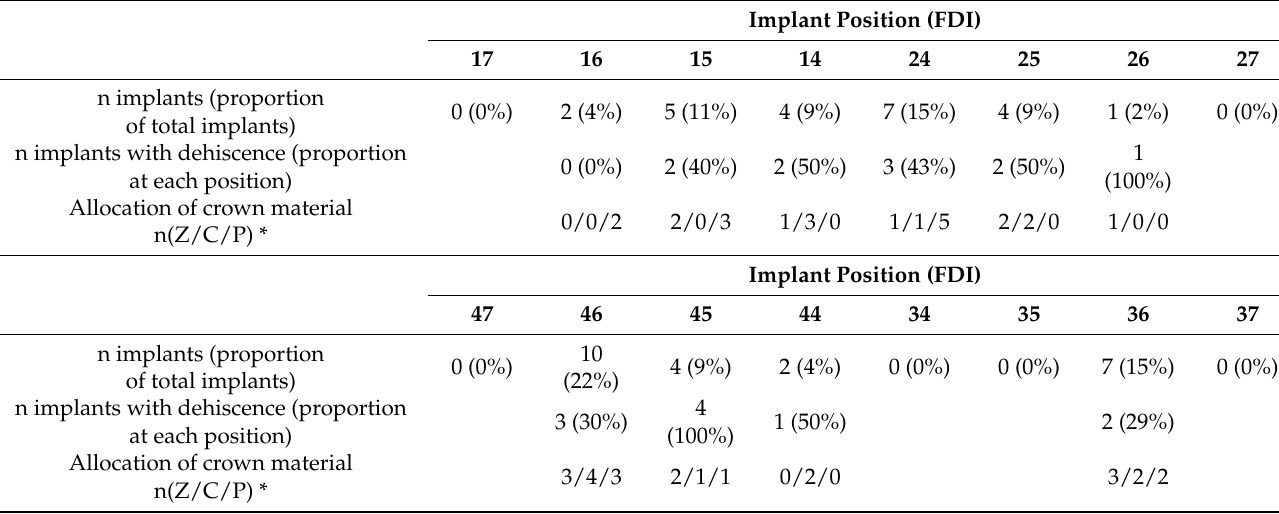
Table 1. Distribution of implants (position according to World Dental Federation notation (FDI)), incidence of buccal osseous dehiscence after implant placement, and randomized allocation of the different crown